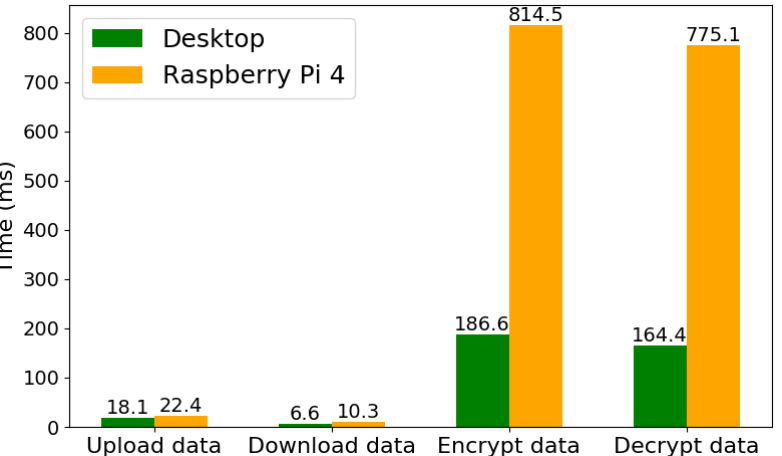
Figure 8. Processing time of meta-data operations: accessing Swarm and symmetric encryption.